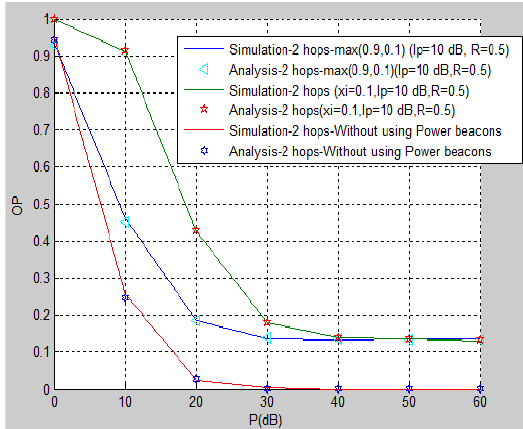
Fig. 3. OP versus P (dB): K=2, (x PU , y PU )= (1,1), R=0.5